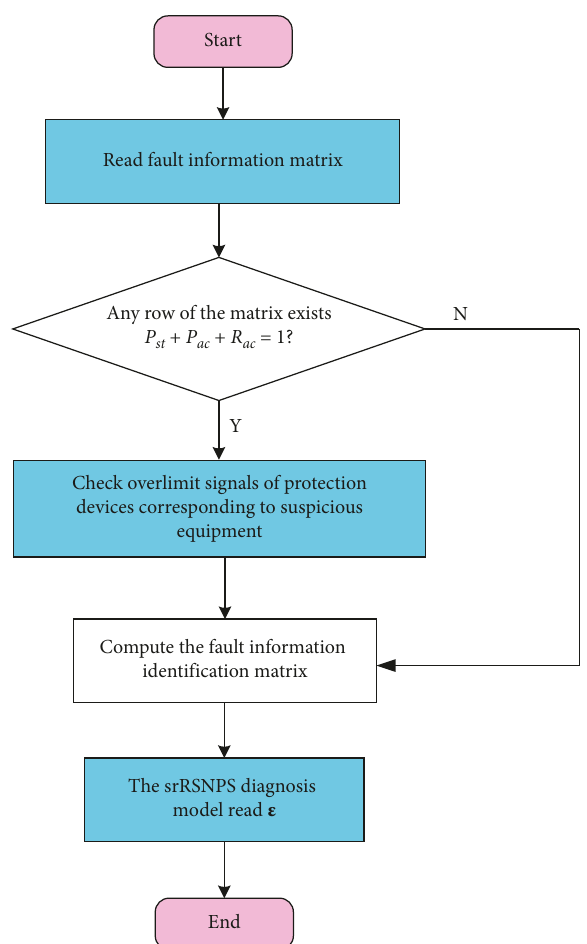
Figure 4: Flowchart of correction steps for action